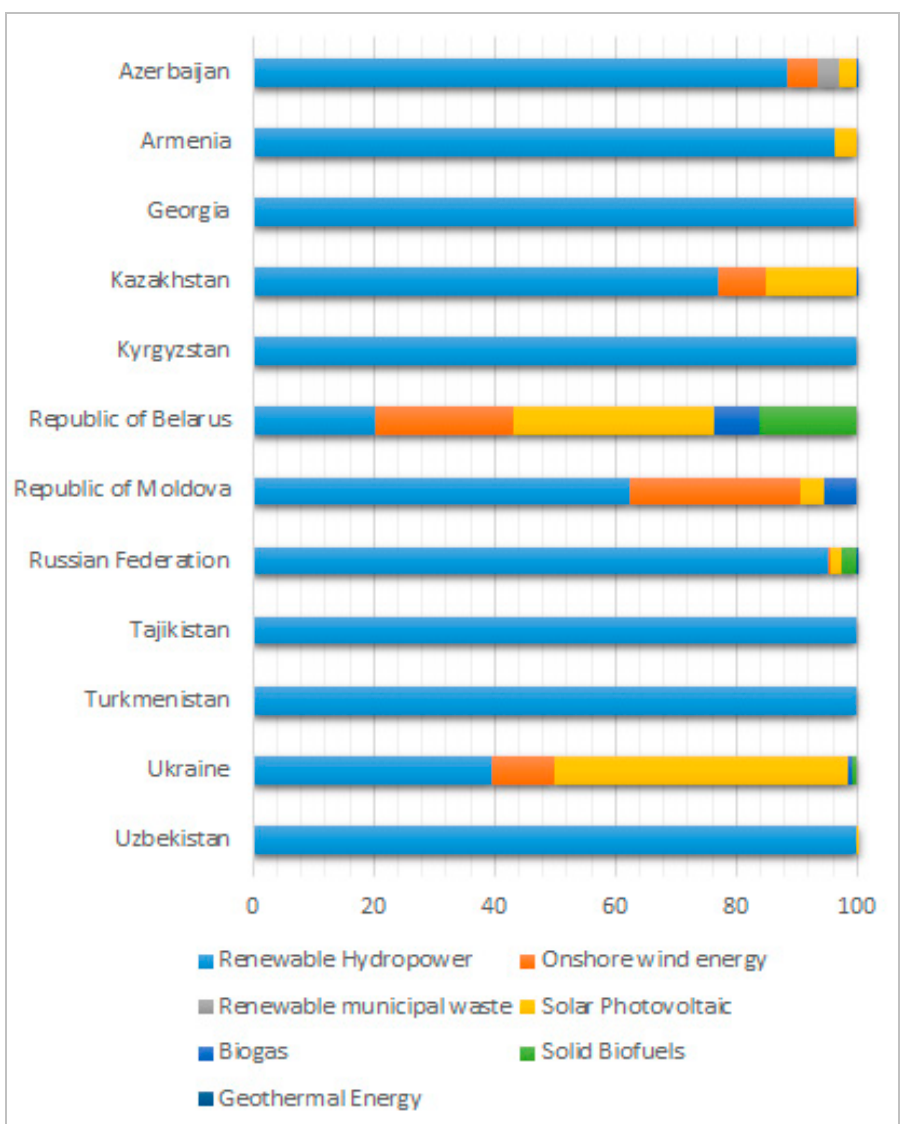
Figure 1. Installed capacity of renewable energy technologies in EECCA countries in 2019. Source: developed by the authors based on statistical data [45].